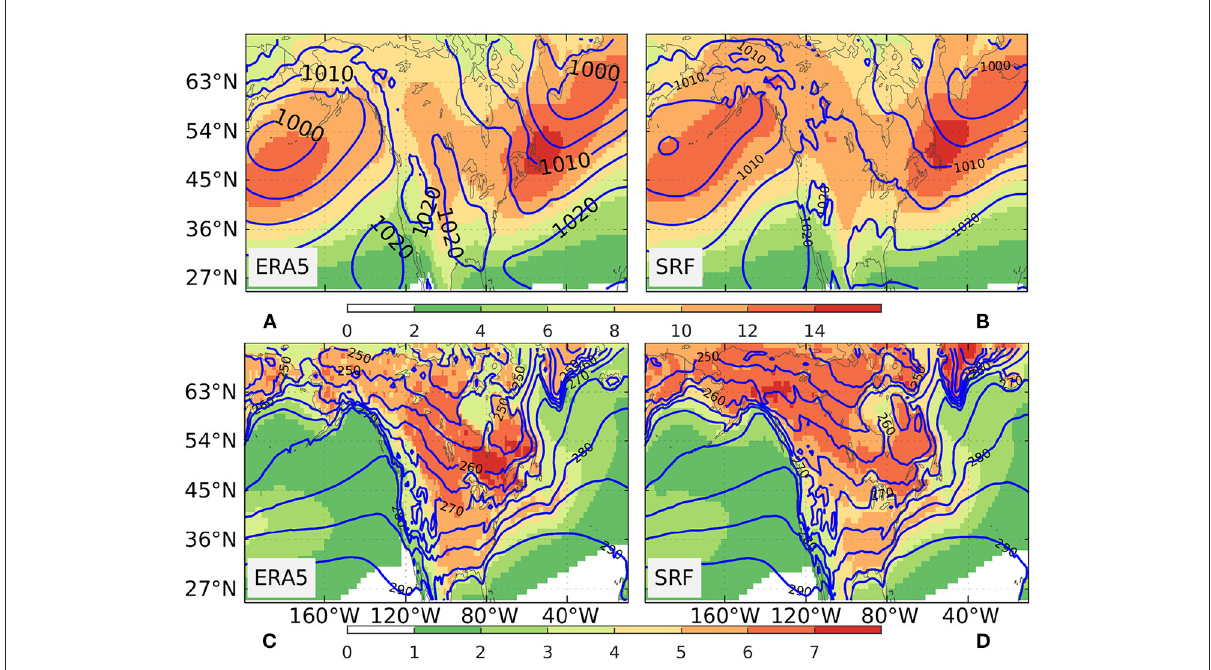
FIGURE2 The climatological seasonal mean (December–February, DJF) sea level pressure (SLP) (contour, units in hPa) and extratropical storm tracks (shading, units in hPa) over the period 1992–2022 from (A) ERA5 data and (B) SRF. The climatological seasonal mean SAT (contour, units in K) and TSI (shading, units in K) for the DJF during 1992–2022 from (C) ERA5 data and (D) SRF.